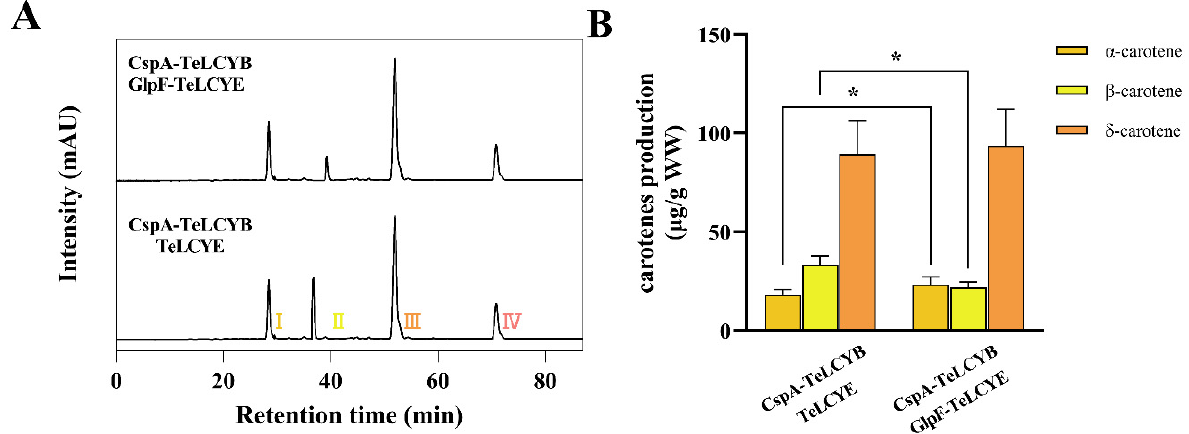
Figure 5. Initiation of membrane-targeted TeLCYE at the starting stage to mediate α -/ β -carotene stoichiometry. ( A ) HPLC spectra of lycopene-accumulating strains harboring pBlue- TeLCYE or pBlue- GlpF - TeLCYE separately co-transformed with pCspA-TeLCYB cultured at 37 ◦ C without cold shock. I, α -carotene; II, β -carotene; III, δ -carotene; IV, lycopene. ( B ) Carotene-accumulation patterns in lycopene-accumulating strains harboring pBlue- TeLCYE or pBlue- GlpF - TeLCYE separately co-transformed with pCspA-TeLCYB cultured at 37 ◦ C without cold shock. (*) p < 0.05.